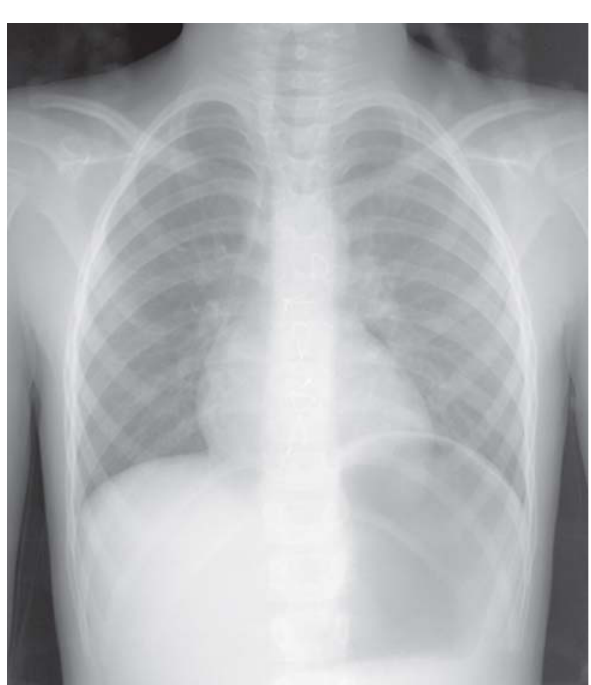
Fig. 2 – Radiografia de tórax pré-operatória com área cardíaca dentro dos limites de normalidade